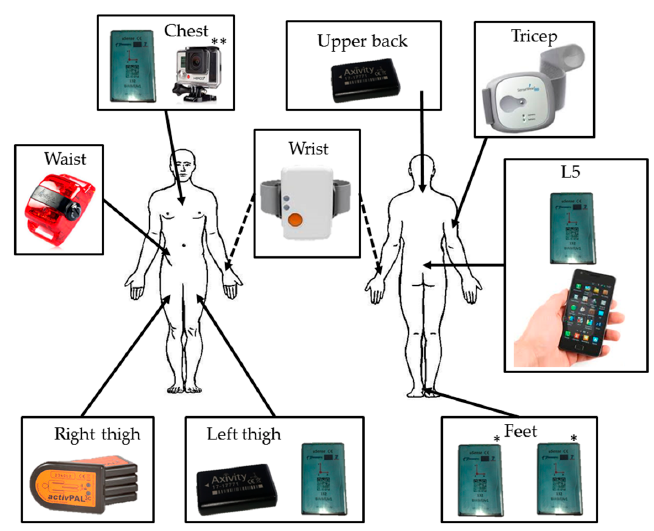
Figure 1. The sensors configuration, where * indicates the sensors that will only be used in the semi-structured protocol, and ** indicates the camera that will be attached for the out-of-lab activities.